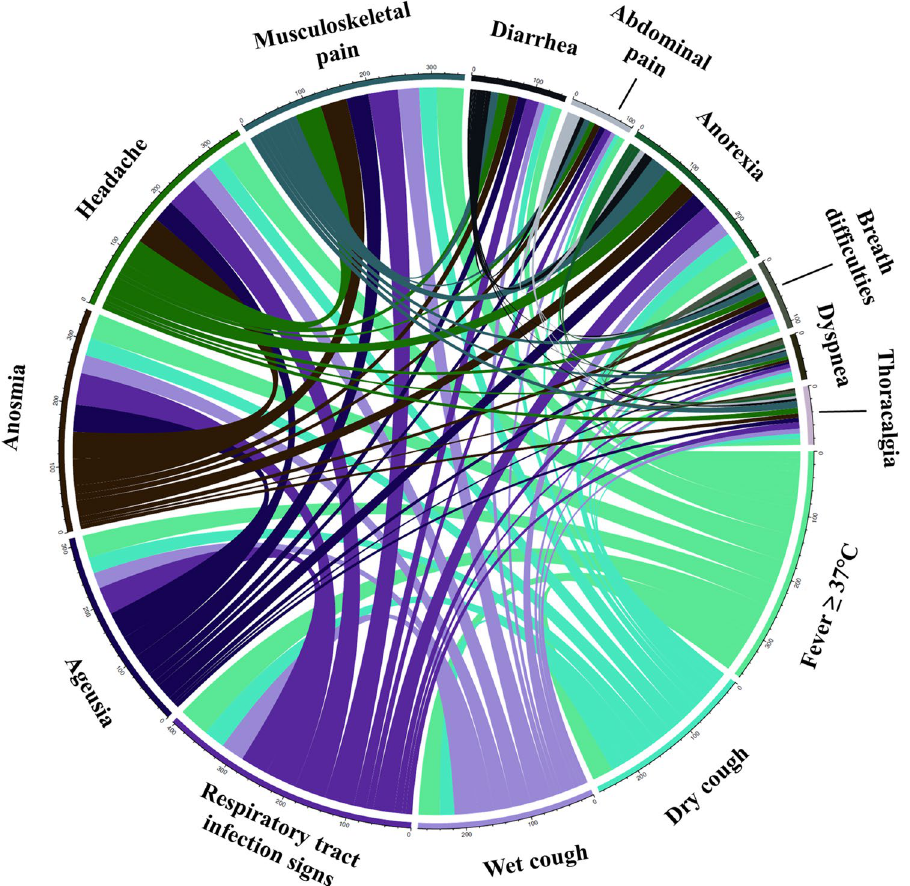
Figure 3. The frequency and co-occurrence of COVID-19 symptoms in outpatients. Circular visualization showing the frequency of symptoms’ co-occurrence. Arc length corresponds to the frequency of symptoms, whereas the width of the ribbons between 2 symptoms shows the frequency of co-occurrence. Only symptoms co-occurring in more than three patients were